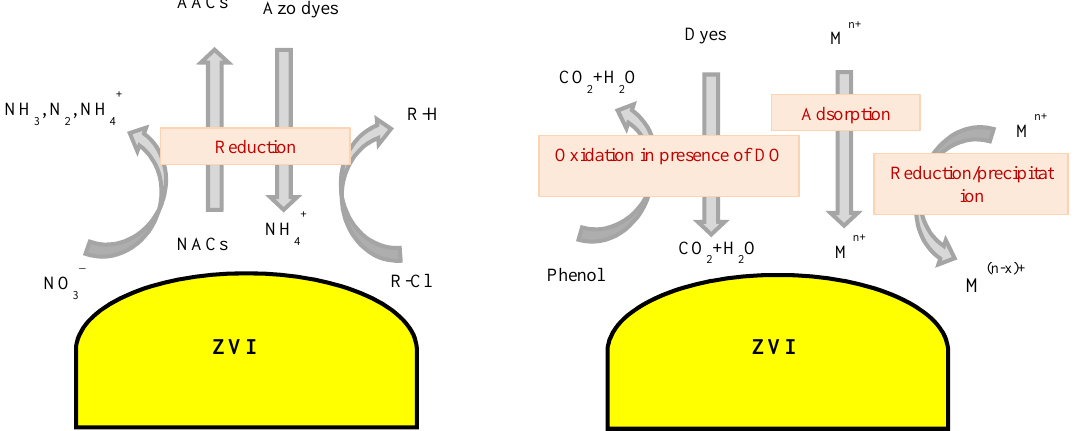
Figure 1. Schematic of pollutants removal by ZVI in the absence of H 2 O 2 . NACs = nitroaromatic compounds; AACs = aminoaromatic compounds.